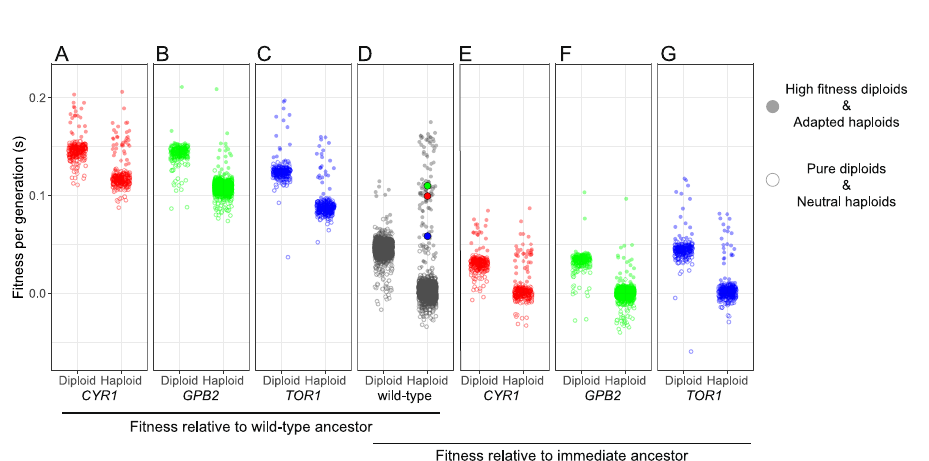
Fig. 3 Distribution of fi tness effects of 1st-step adapted clones following further adaptation. Fitness values of isolated clones are shown with respect to the wild-type ancestor ( A – D ), and with respect to their immediate adapted ancestor ( D – G ). Fitness was measured in a pooled fashion from isolated clones of all immediate ancestor evolutions (including the wild-type), and arranged by ancestor (as annotated at the bottom). Haploids and diploids are shown in separate columns for each genotype. Clones with increased fi tness within each group (high fi tness diploids and adapted haploids) carry different annotation from pure diploids and neutral haploids. Larger dots in the ancestor cloud represent the adapted ancestors prior to barcoding and are color- coded to match the respective genotypes. Fitness values are provided in the Source data